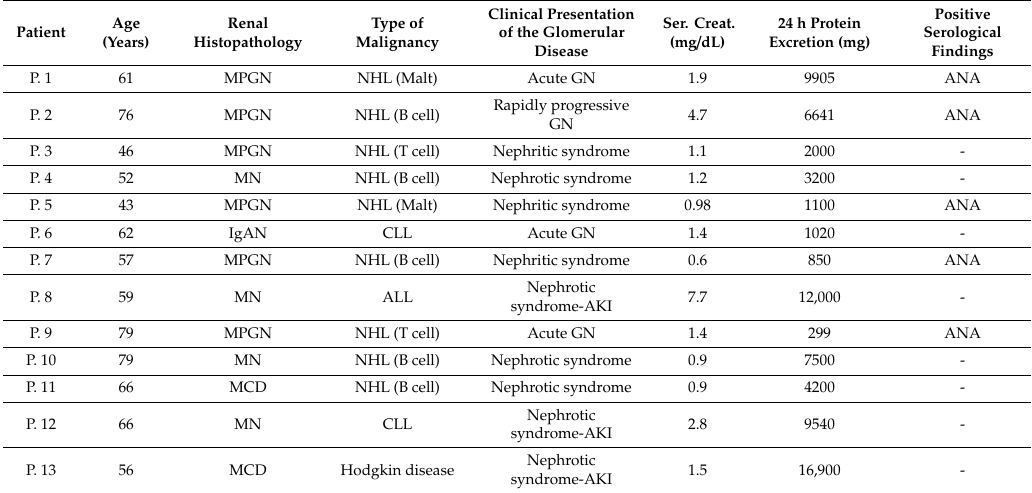
Table 1. Characteristics of the patients with glomerular diseases associated with malignancies (GDAM) presenting lymphoid malignancies at the diagnostic kidney